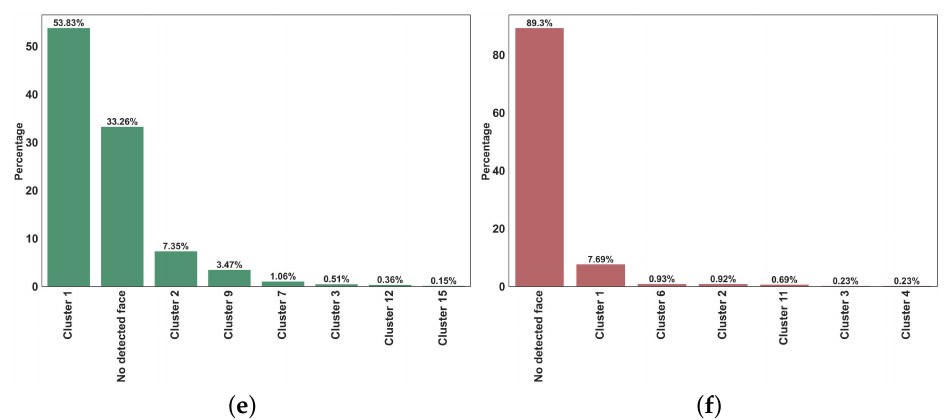
Figure 13. The result of YOLO on the dataset. ( a ) Logo detection on the #Nike hashtag. ( b ) Logo detection on the #Gucci hashtag. ( c ) Face recognition on the #CristianoRonaldo hashtag with a Match label. ( d ) Face recognition on the #CristianoRonaldo hashtag with a Mismatch label. ( e ) Face recognition on the #EdSheeran hashtag with Match label. ( f ) Face recognition on the #EdSheeran hashtag with Mismatch